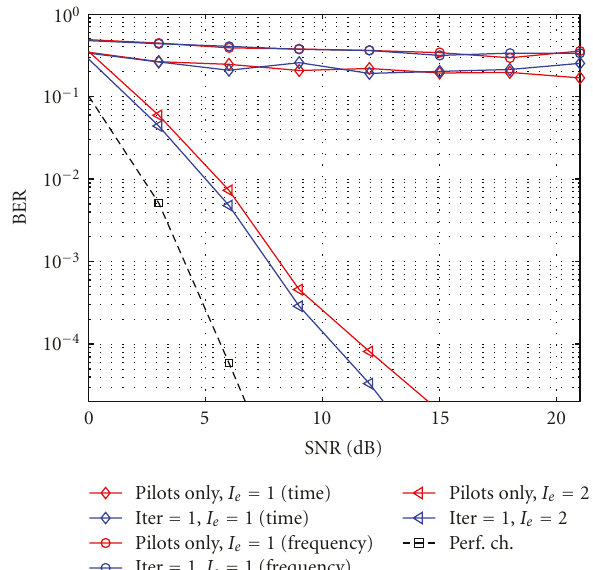
Figure 5: E ff ect of a priori correlation knowledge on the perfor- mance of the receiver.